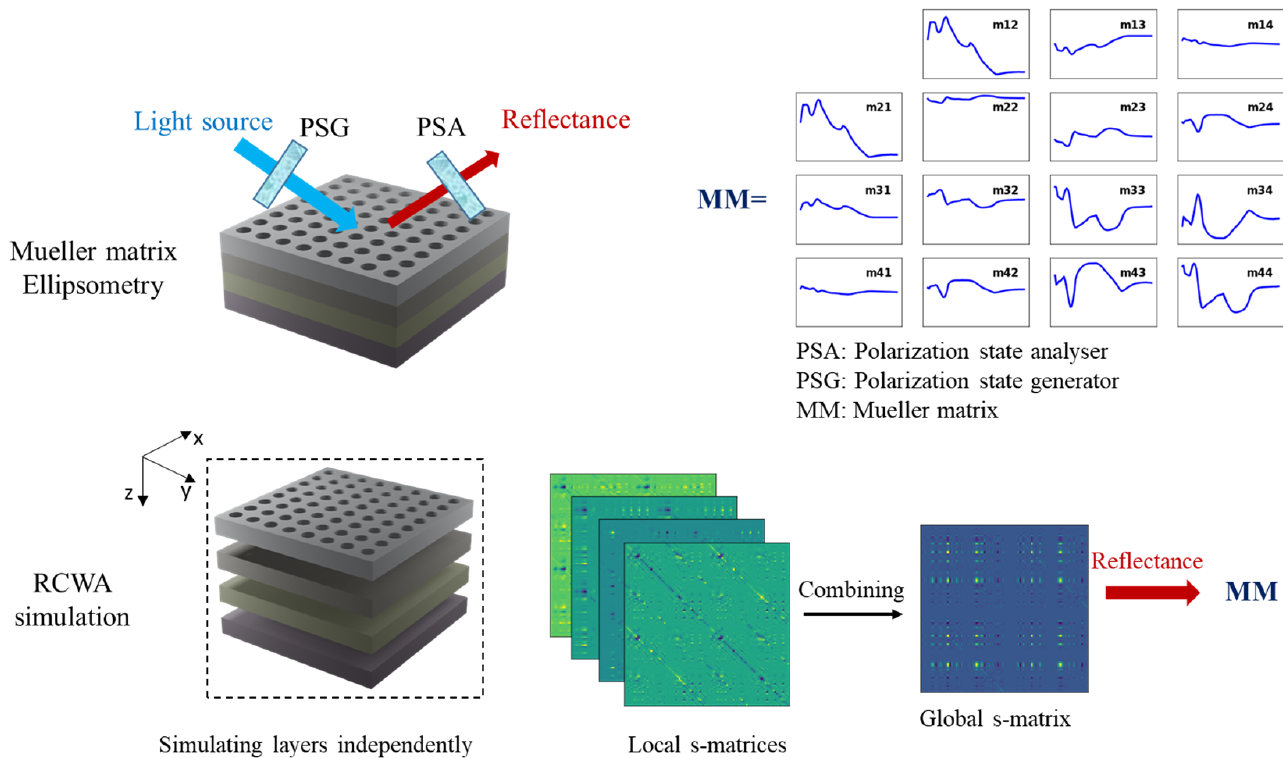
Figure 1. Schematic of Mueller matrix ellipsometry and RCWA simulation of multilayers. By measuring all polarizing states of reflected waves, the metrological information of the multilayers is contained in the Mueller matrix (MM). In the RCWA method, local layers are independently simulated and combined for the global s-matrix to quantify reflectance to compute MM in a wide range of measured wavelengths.